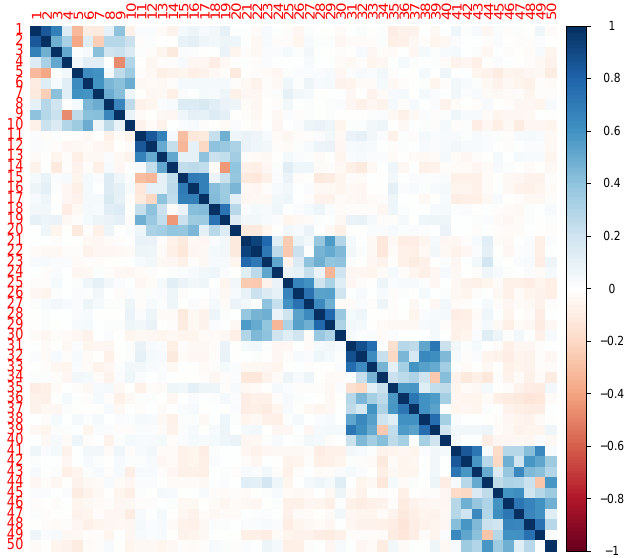
Figure 2. Correlation of the 50 simulated single nucleotide pollymorphisms (SNPs) in linkage disequilibrium (LD). The vertical color line to the right indicates the level of correlation between the SNPs. The dark blue (red) means high positive (high negative) correlation and the light blue (red) means low positive (low negative) correlation.